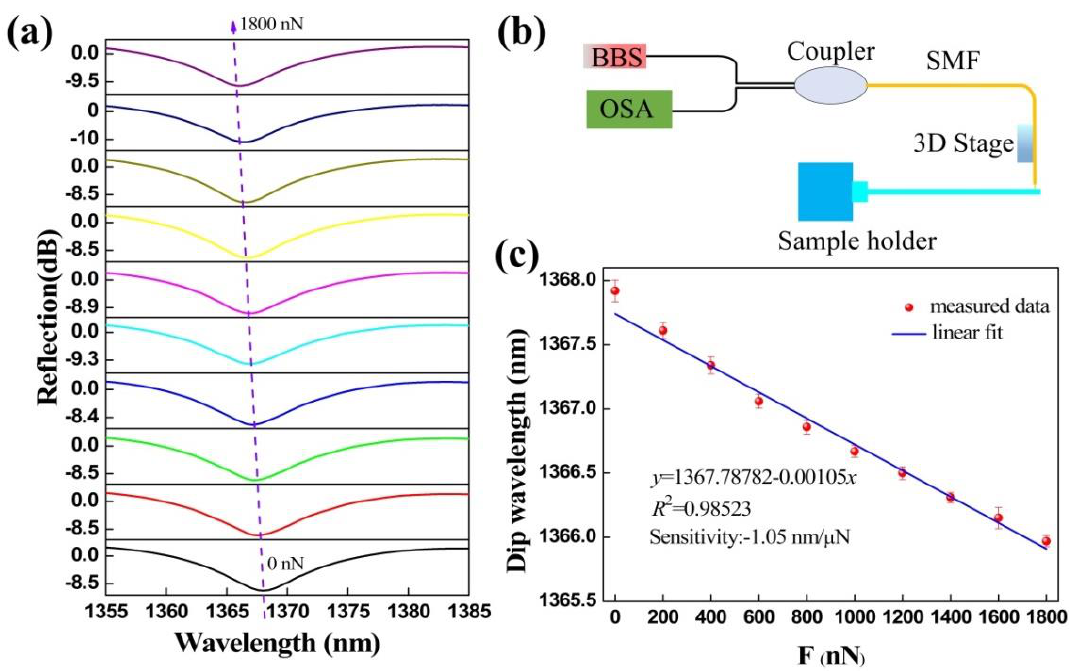
Figure 4. Microforce measurements. ( a ) Reflection spectral evolution of the FTMS while the external force increases from 0 to 1800 nN. ( b ) Measurement system setup. ( c ) Linear relationship between dip wavelength and microforce. The line is the linear fitting of measured data points and the error bar is obtained by critically repeating the experiment of force measurement three times.